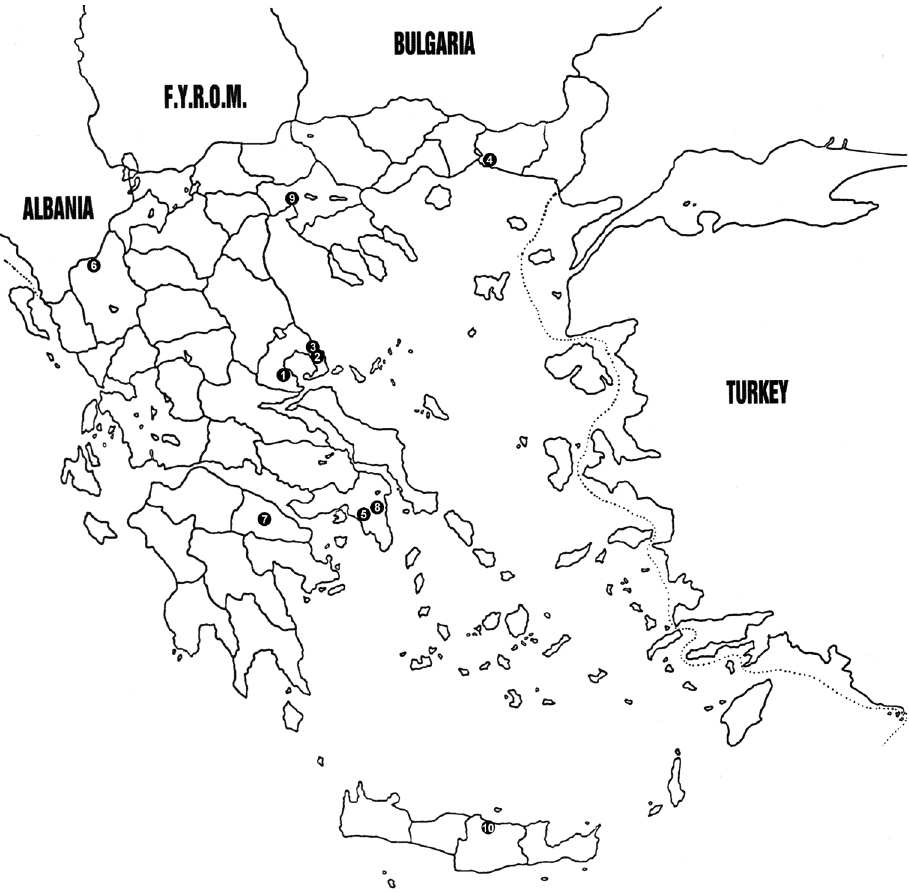
Figure 1. Investigated areas marked on the map of Greece: 1 Almyros (Thessaly) 2 Agios Ioannis (Thes- saly) 3 Agrioleukes (Thessaly) 4 Arogi (Thrace) 5 Athens (central Greece) 6 Grammos (Epirus) 7